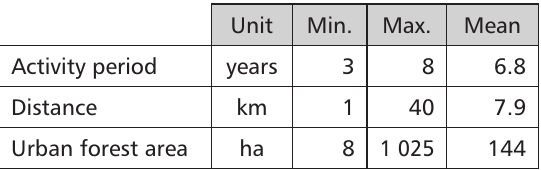
General characteristics of urban